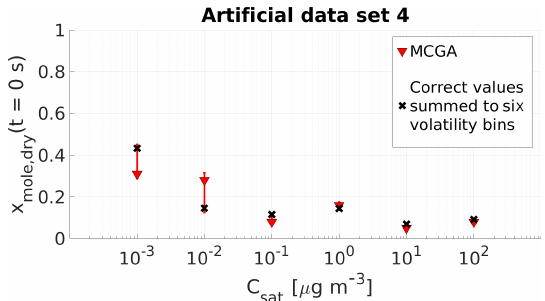
Figure 5. Parameter estimates for artificial data set 4 dry particle mole fraction at the start of the evaporation of six model compounds with predefined saturation concentration were optimized to match the data. Red triangles show the MCGA estimates and the whiskers show the 10th and 90th percentiles of the estimated variable distri- butions. Black crosses are the correct values summed to six volatil- ity bins. All the correct values for the 40 evaporating compounds are listed in Table